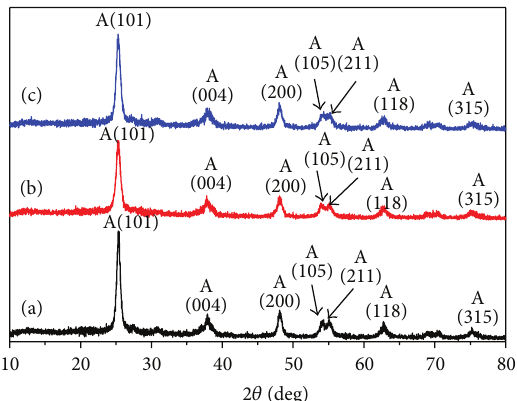
Figure 6: XRD pattern of synthesized TiO 2 nanoparticles: (a) 0% AC, (b) 5% AC, and (c) 10% AC (A: